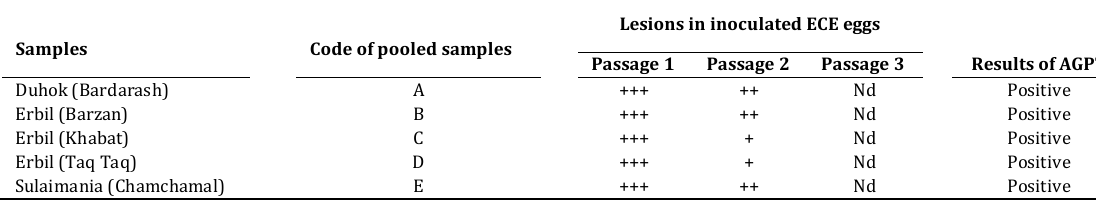
Lesions in inoculated ECE eggs